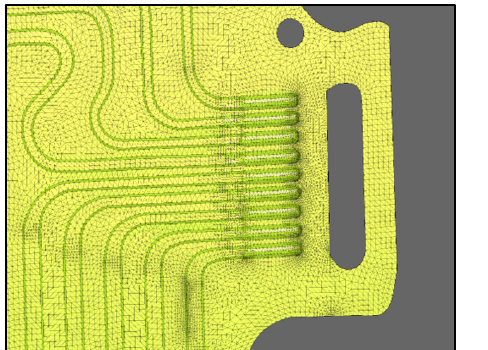
Figure 5. Meshing in all nine inlet channels and top side of cold plates in DEP MeshWorks 8.0.